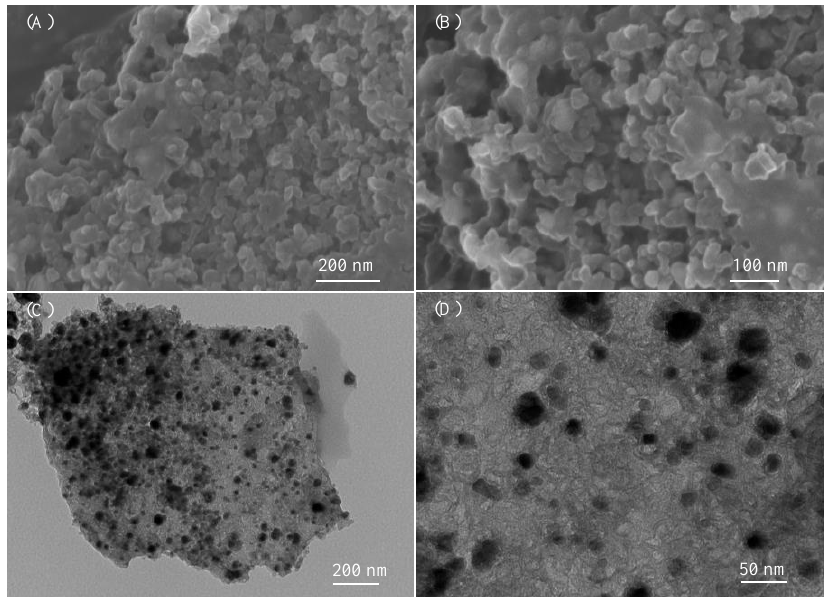
Figure 3. ( A , B ) SEM images and, ( C , D ) TEM images of Co/CoO@NCS.